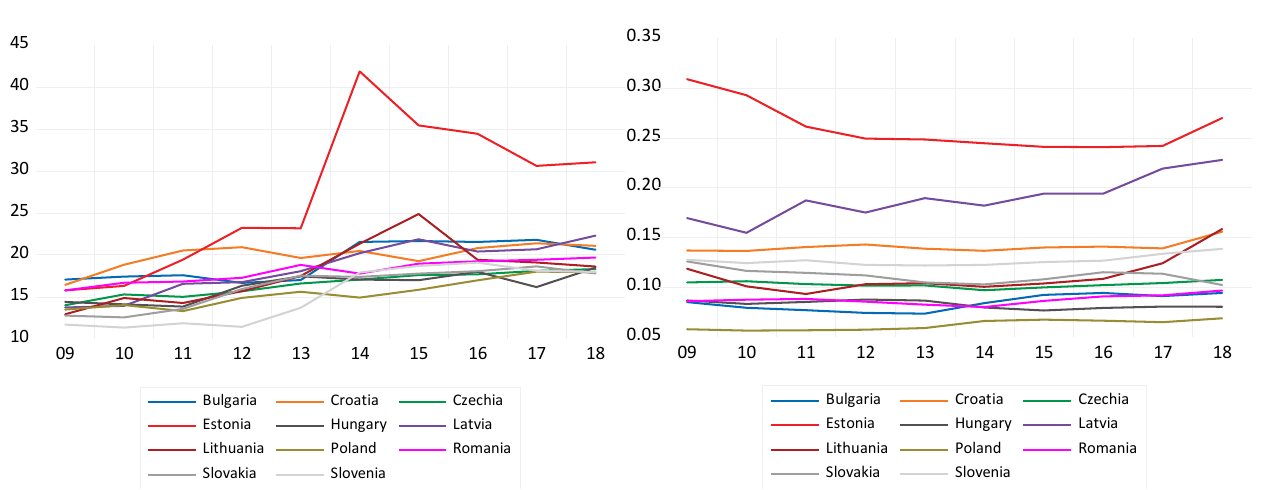
garia, Romania, Croatia, Slovenia, Poland, Lithuania and Slovakia). The unemployment rate, the last macroeconomic variable used in our research, was on a robust downward trend in all CEE countries after 2009, although it somewhat increased between 2011 and 2013. Thus, the 11 countries included in our analysis had unemployment rates ranging between 5.86% (Slovenia) and 17.51% (Latvia) in 2009, but only ranging between 2.24%